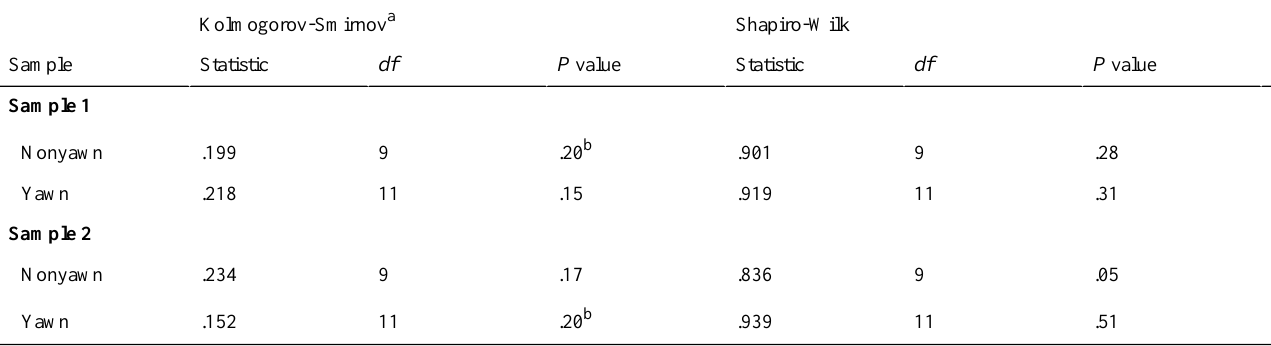
Table 3. Normality testing of